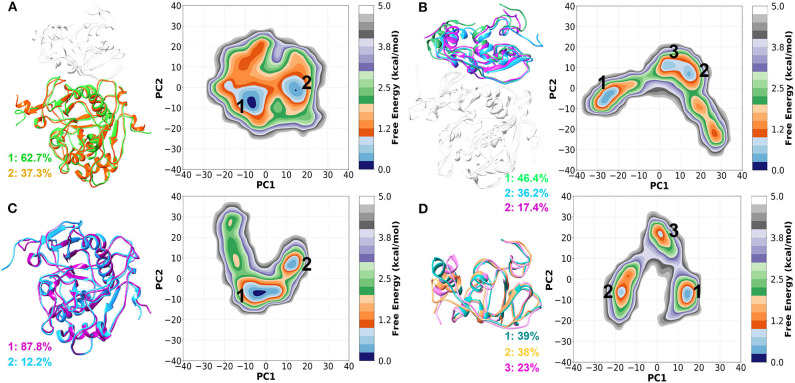
Two-dimensional FEL generated by projecting the first two principal components, PC1 and PC2 for (A) nsp16complex (nsp16 in nsp16/nsp10/SAM), (B) nsp10complex (nsp10 in nsp16/nsp10/SAM), (C) nsp16SAM (nsp16/SAM), and (D) nsp10apo. The representative structures are shown on the left panel.